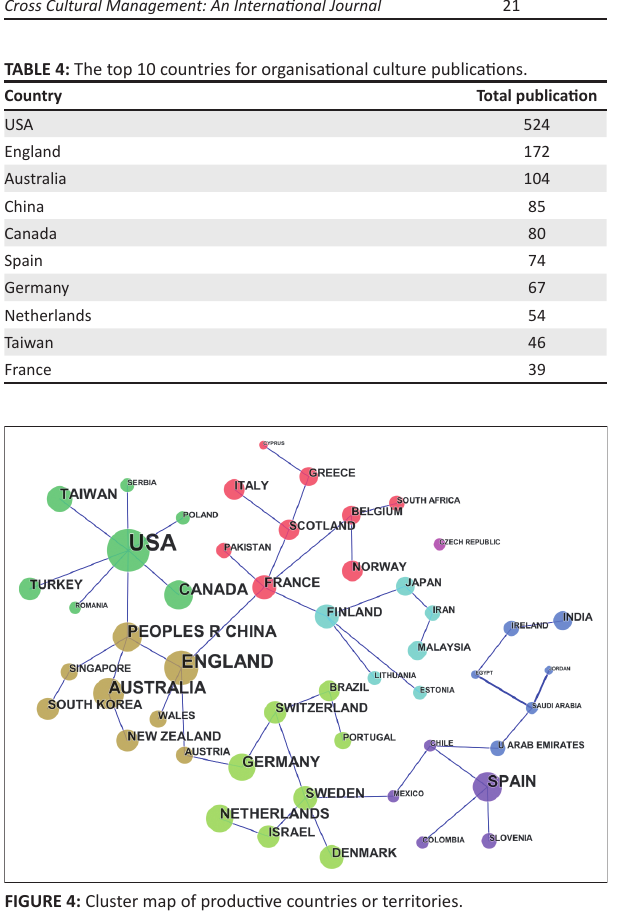
FIGURE 4: Cluster map of productive countries or territories.